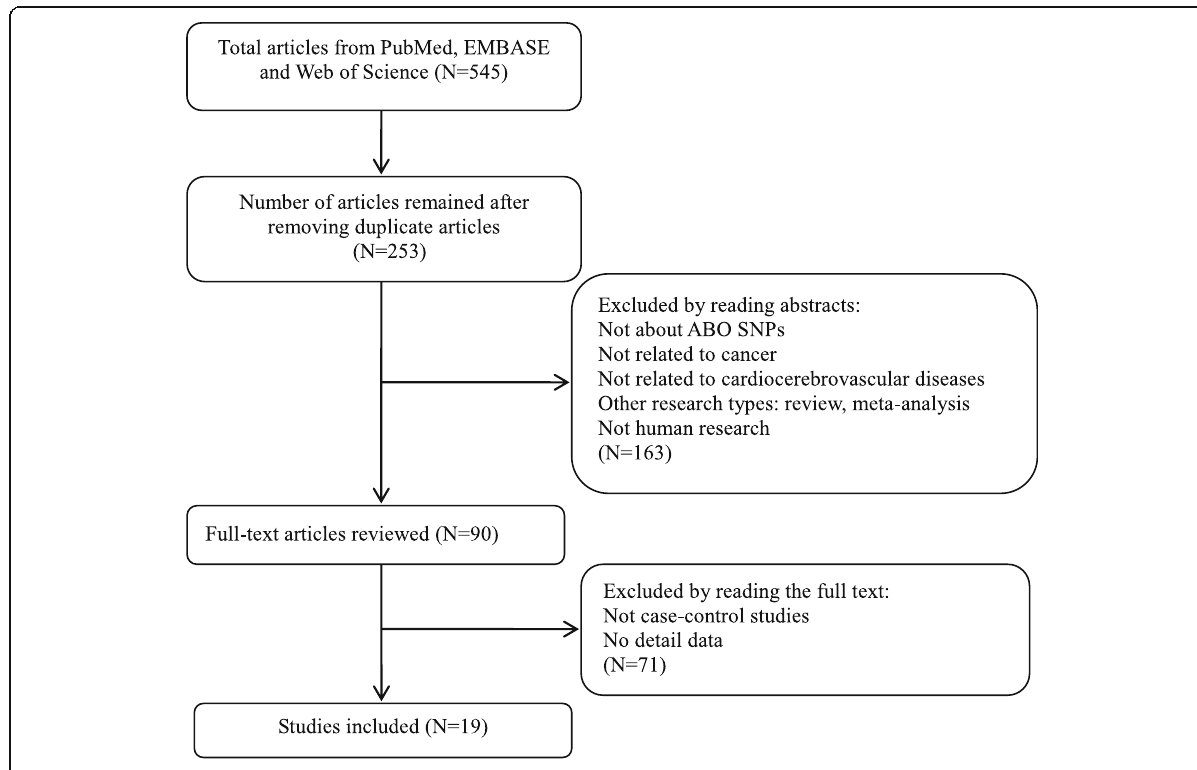
Fig. 1 Flow chart of the study selection